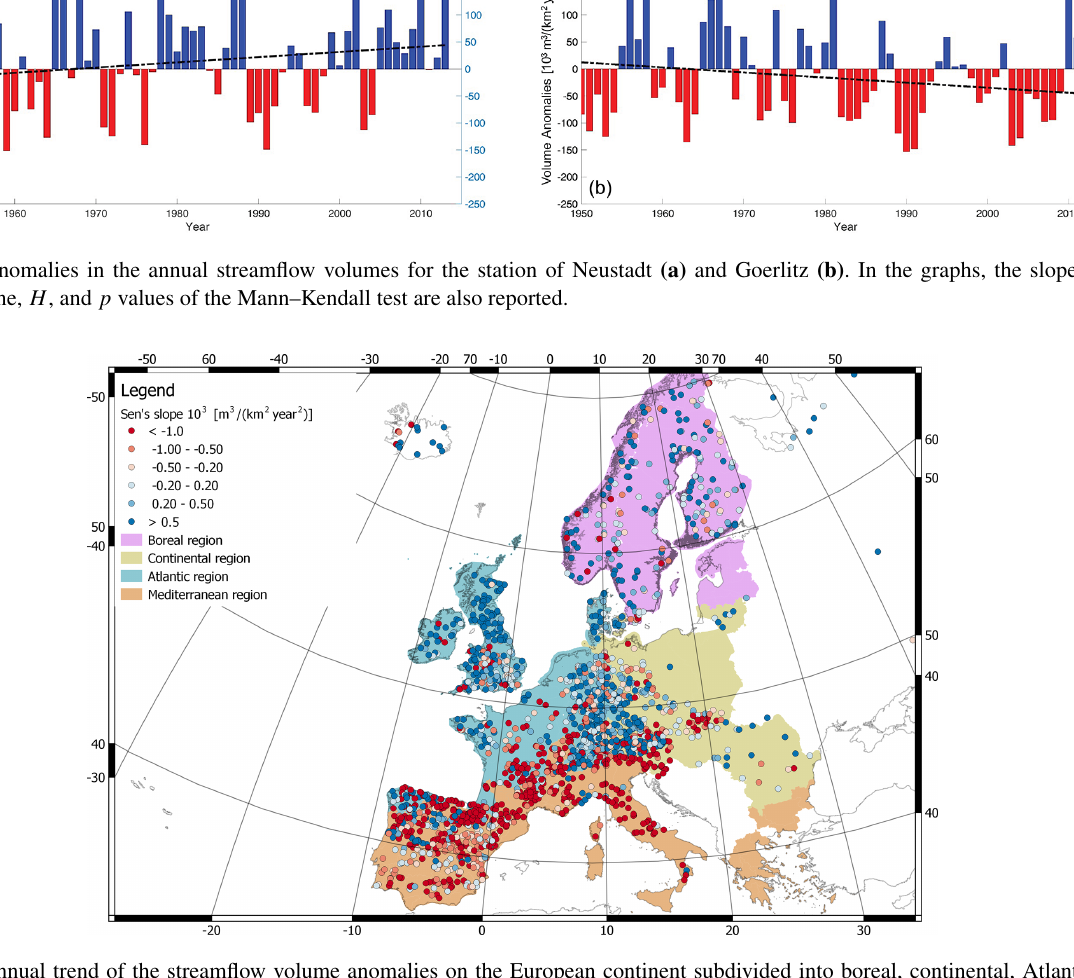
Figure 5. Annual trend of the streamflow volume anomalies on the European continent subdivided into boreal, continental, Atlantic, and Mediterranean regions. Only significant trends are